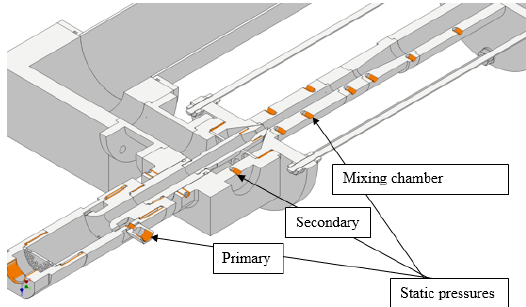
Fig. 6. The cut view of ejector model